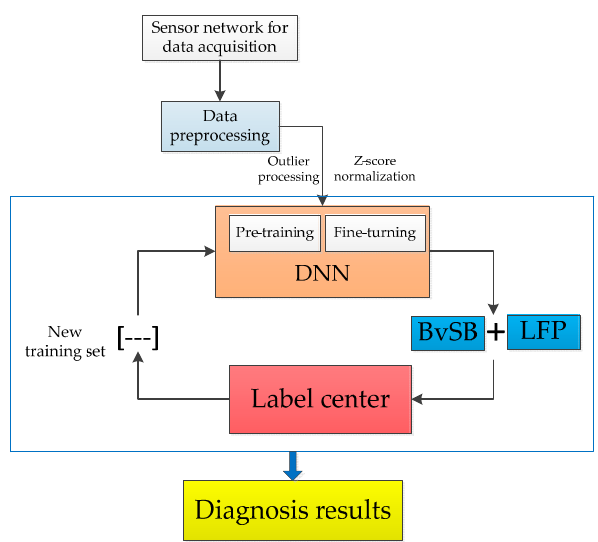
Figure 2. An illustration of proposed method for chemical fault diagnosis.